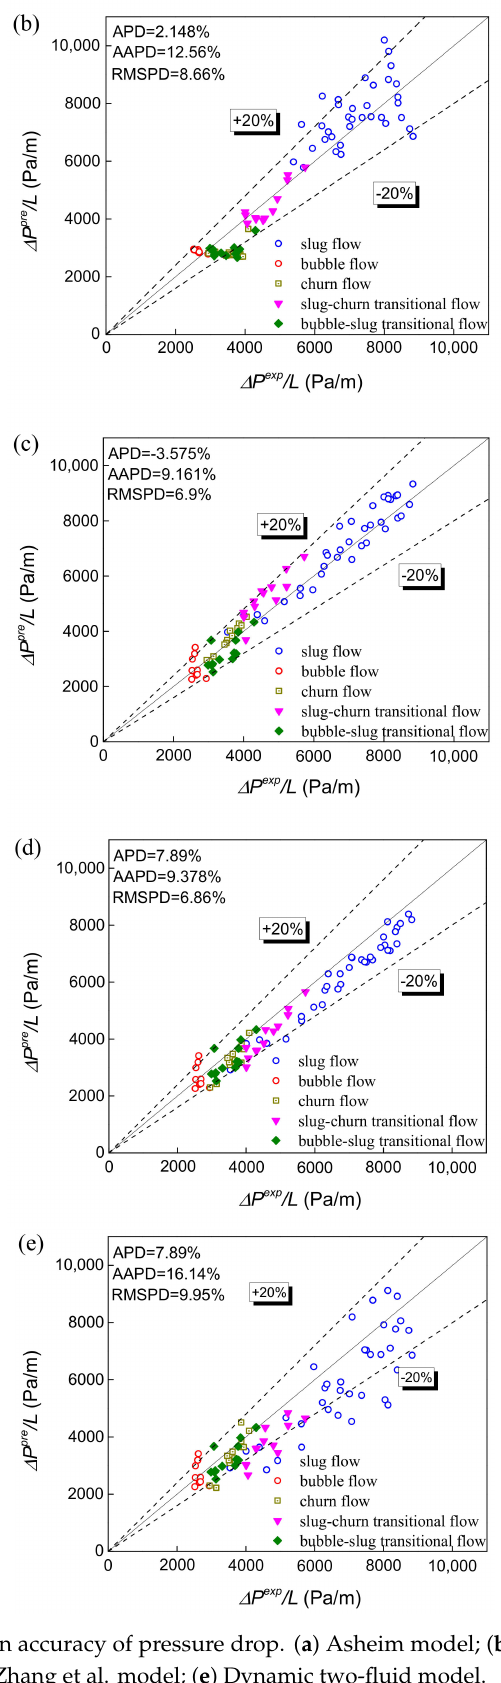
Figure 10. The prediction accuracy of pressure drop. ( a ) Asheim model; ( b ) Hasan-Kabir model; ( c ) Ansari et al. model. ( d ) Zhang et al. model; ( e ) Dynamic two-fluid